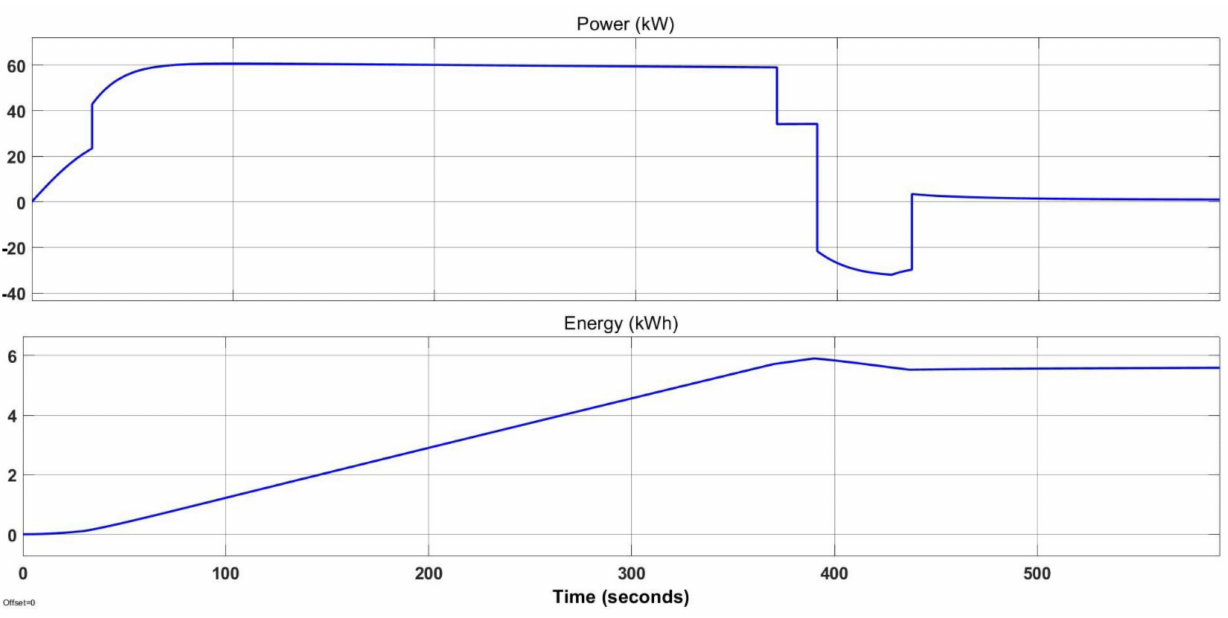
Figure 11. Power demand and energy consumption of electric PZL-101 Gawron—tow at height 600